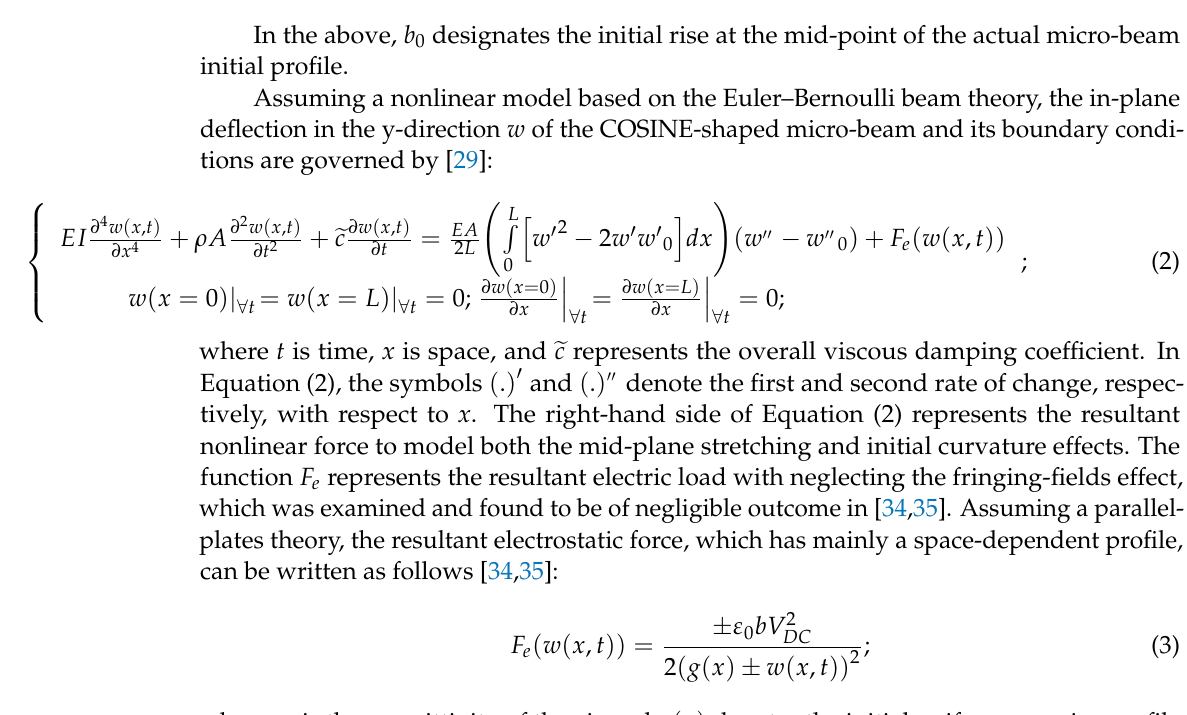
Figure 2. The static displacement of micro-beams with a uniform and a non-uniform g under DC electrostatic actuation ( V DC ) for ( a ) Case 1 and ( b ) Case 2 (solid: stable, dashed: unstable).